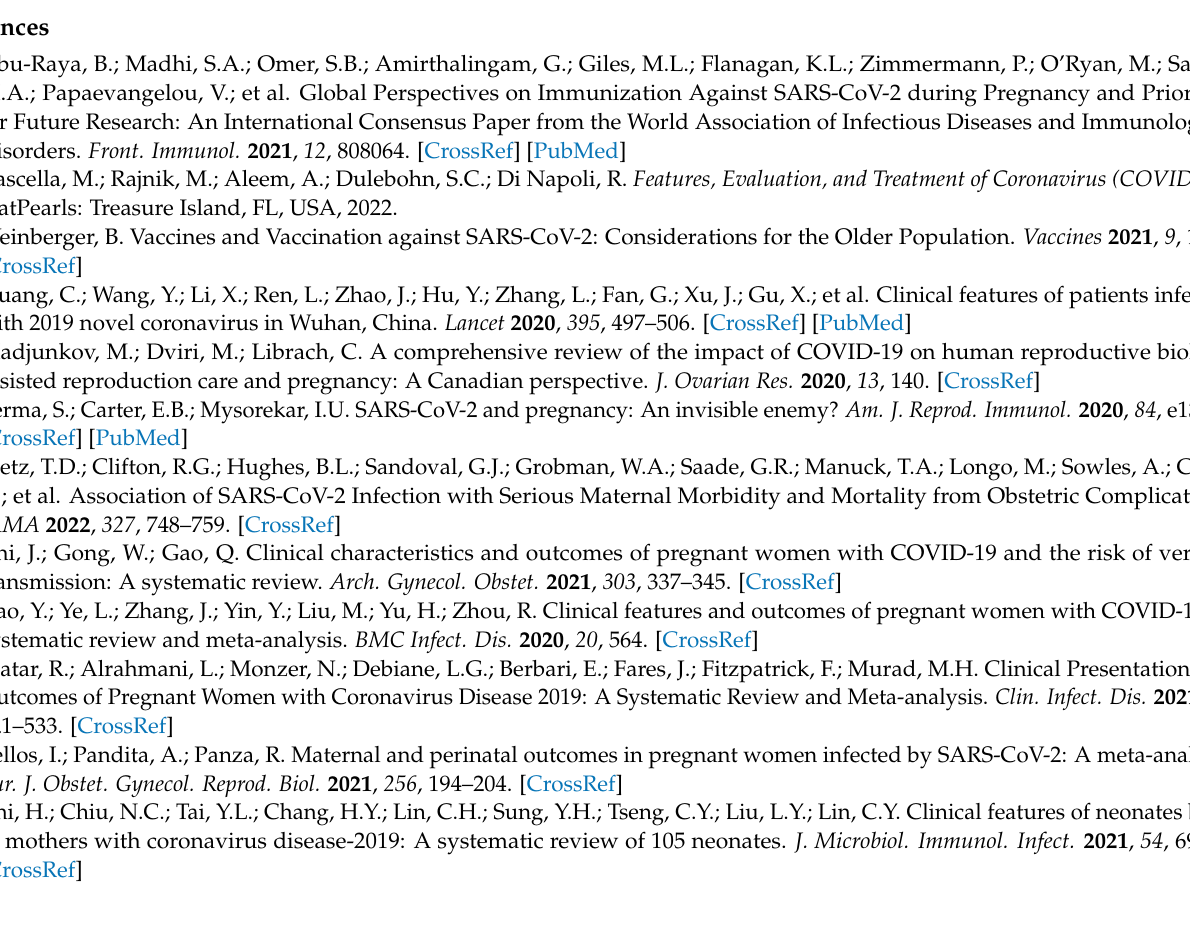
symptoms. Table S3: Characteristics of symptomatic SARS-CoV-2 positive mothers and their children as compared to healthy controls. Table S4: Characteristics of asymptomatic SARS-CoV-2 positive mothers and their children as compared to healthy